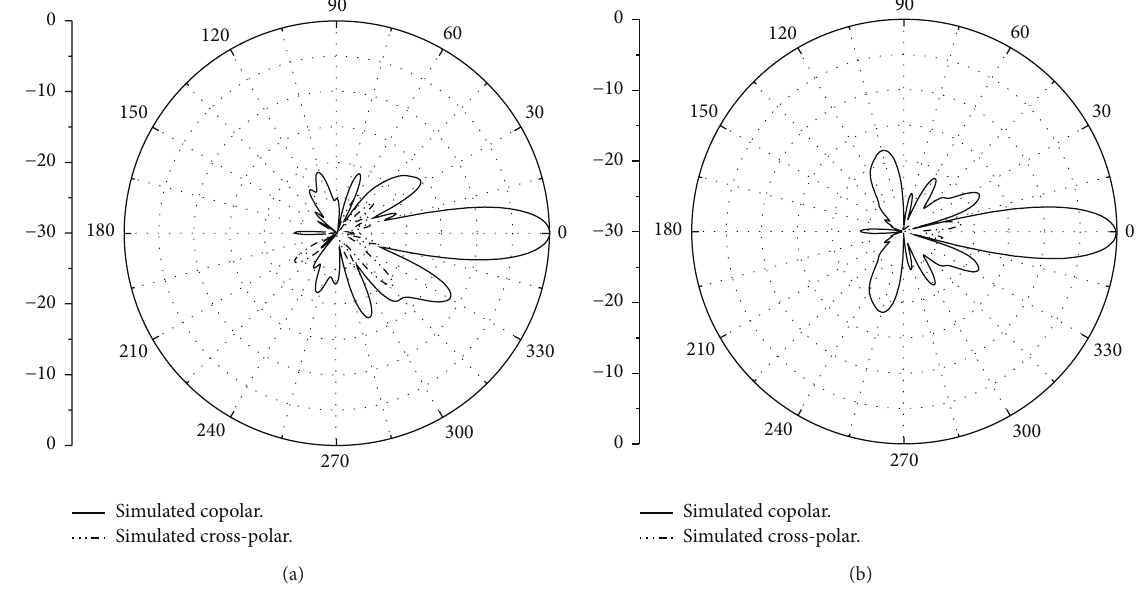
Figure 4: Simulated radiation patterns on the 𝑋𝑍 plane and 𝑌𝑍 plane: (a) 𝑋𝑍 plane; (b) 𝑌𝑍